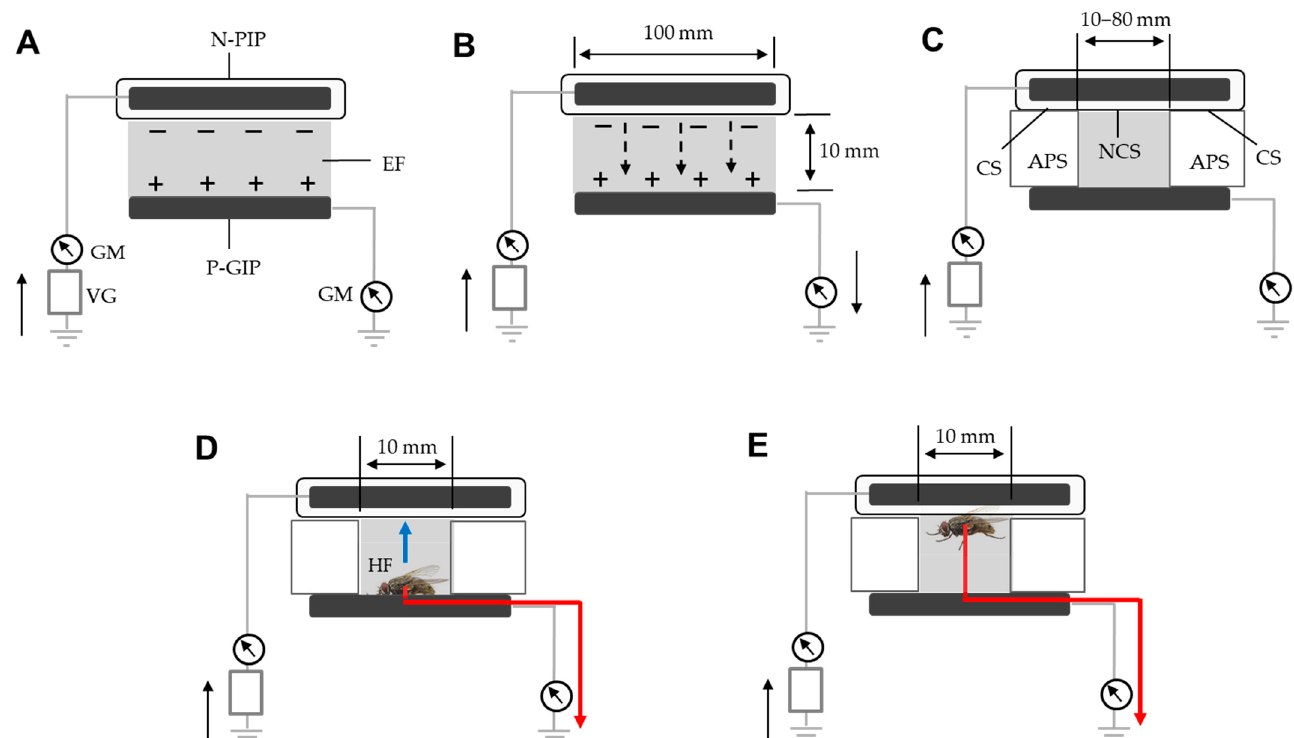
Figure 3. Electric current generation by instrument- and insect-derived discharge in an EFP negatively charged by different applied voltages. ( A ) No discharge occurs from the negatively charged iron plate in the lower voltage range ( − 1 to − 7.9 kV), where an insulating PVC membrane prevents the release of negative electricity from the charged iron plate. ( B ) Silent discharge occurs at > − 8.0 kV, and the amount of charge released increases in direct proportion to the increase in applied voltage. This discharge was recorded as a stable electric current to the ground by a galvanometer integrated into the ground line of the grounded iron plate. ( C ) Acrylic plate spacer (APS) insulators inserted between the N-PIP and P-GIP to intercept electricity released from the closed surface of the N-PIP at higher voltages ( − 8 to − 15 kV). ( D ) Housefly (HF)-derived discharge occurs when the fly is attracted to the N-PIP (blue arrow). This discharge is recorded as a specific transient electric current. ( E ) Subsequent discharge from the attracted fly. Solid black arrow indicates the direction of electricity movement from ground to ground. Dotted black arrow indicates electricity movement through silent discharge. Red arrow indicates insect-derived electric current. APS, acrylic plate spacer; CS, closed surface of the N-PIP; EF, electric field; GM, galvanometer; NCS, non-closed surface of the N-PIP; N-PIP, negatively charged PVC-insulated iron plate; P-GIP, positively charged grounded iron plate; VG, voltage generator.